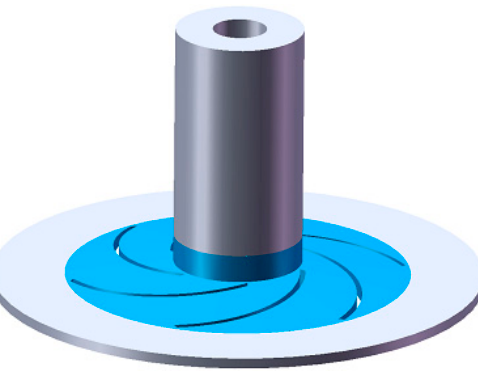
Figure 2. Geometry of the computation domain.